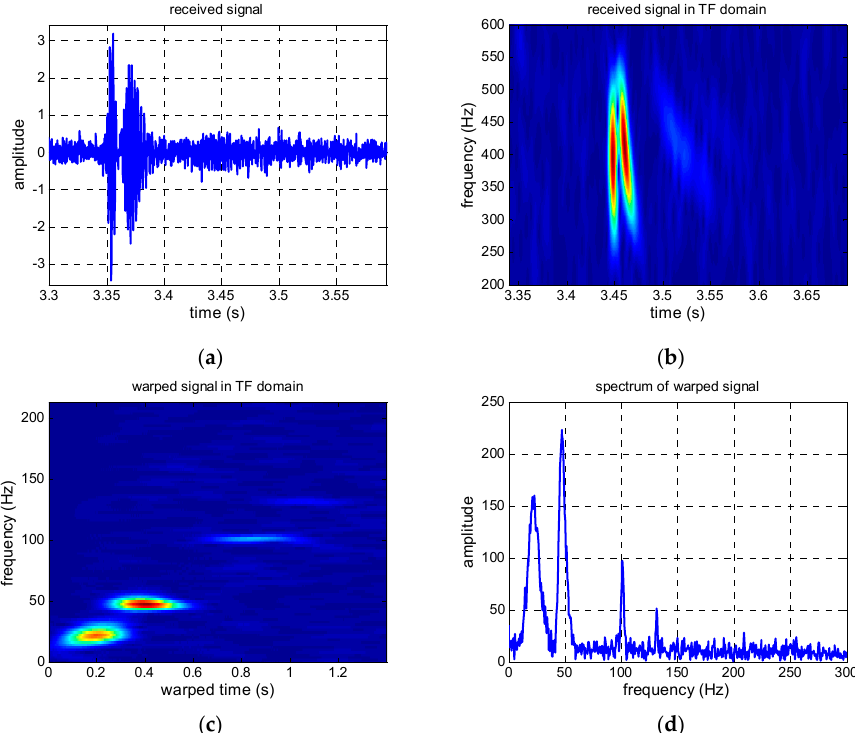
Figure 11. ( a ) Received signal in the time domain; ( b ) received signal in the TF domain; ( c ) warped signal in the TF domain; ( d ) spectrogram of the warped signal.